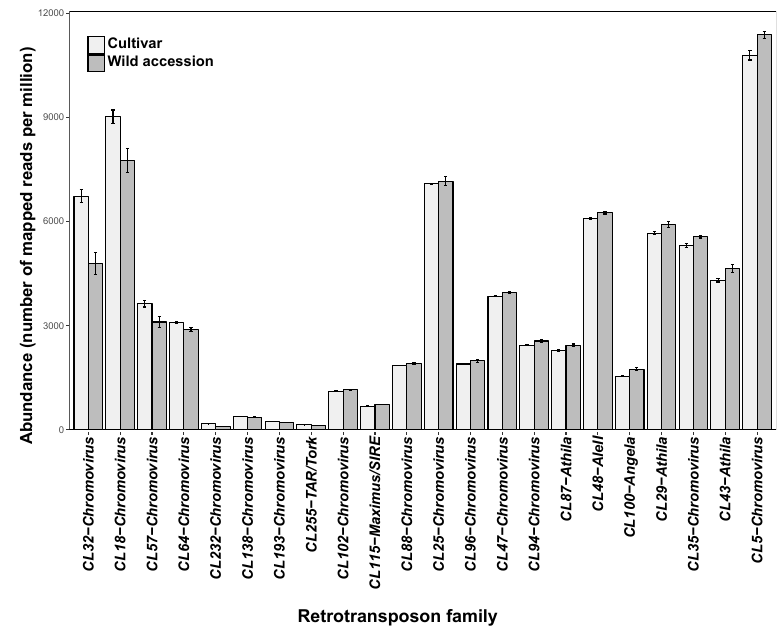
Figure 2. Mean number ( ± standard error) of mapped reads (x million) of each of the 22 LTR-RE families in eight cultivars and seven wild accessions of H. annuus . All families were differentially abundant by PERMANOVA, at p <